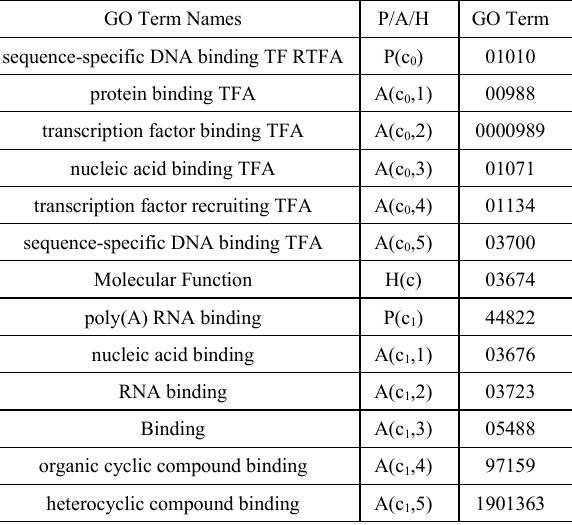
Table 4. GO term